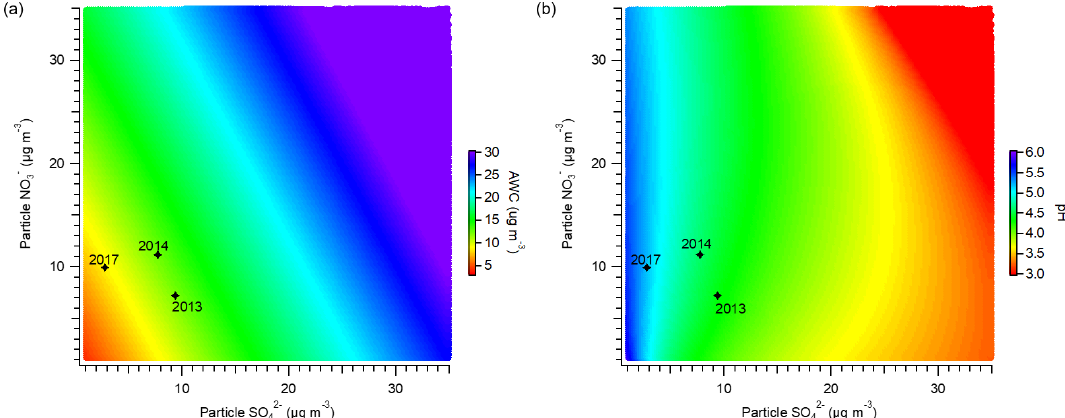
Figure 9. Sensitivity of (a) AWC and (b) particle pH to the mass concentrations of particulate sulfate and nitrate. The stars indicate the average winter conditions for the years 2013, 2014, and 2017.